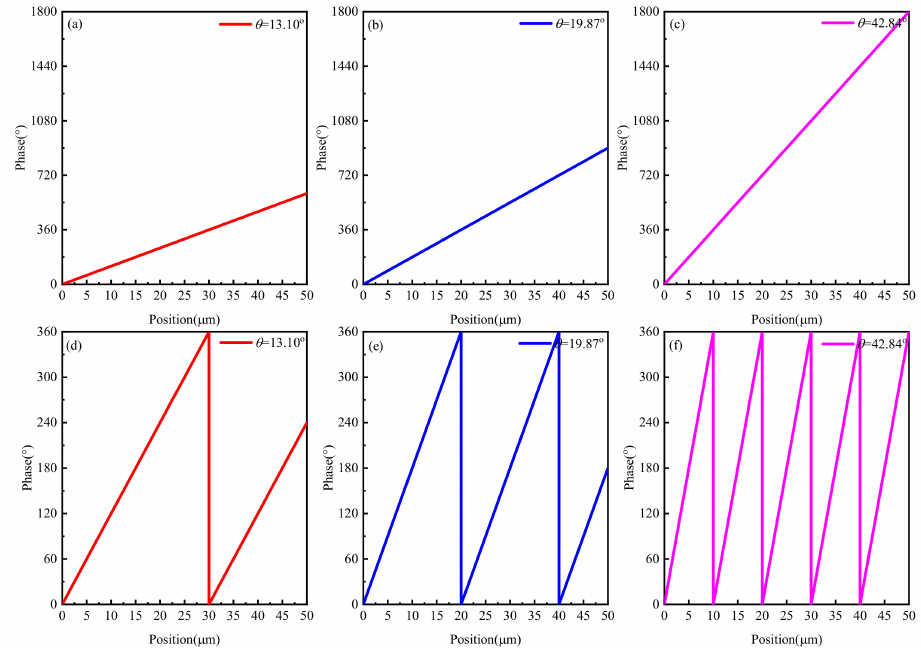
Figure 7. Theoretical results of phases corresponding to deflection angles of ( a ) 13.10 ◦ , ( b ) 19.87 ◦ and ( c ) 42.84 ◦ . Theoretical results of phases corresponding to deflection angles of ( d ) 13.10 ◦ , ( e ) 19.87 ◦ and ( f ) 42.84 ◦ according to a period of 360 ◦